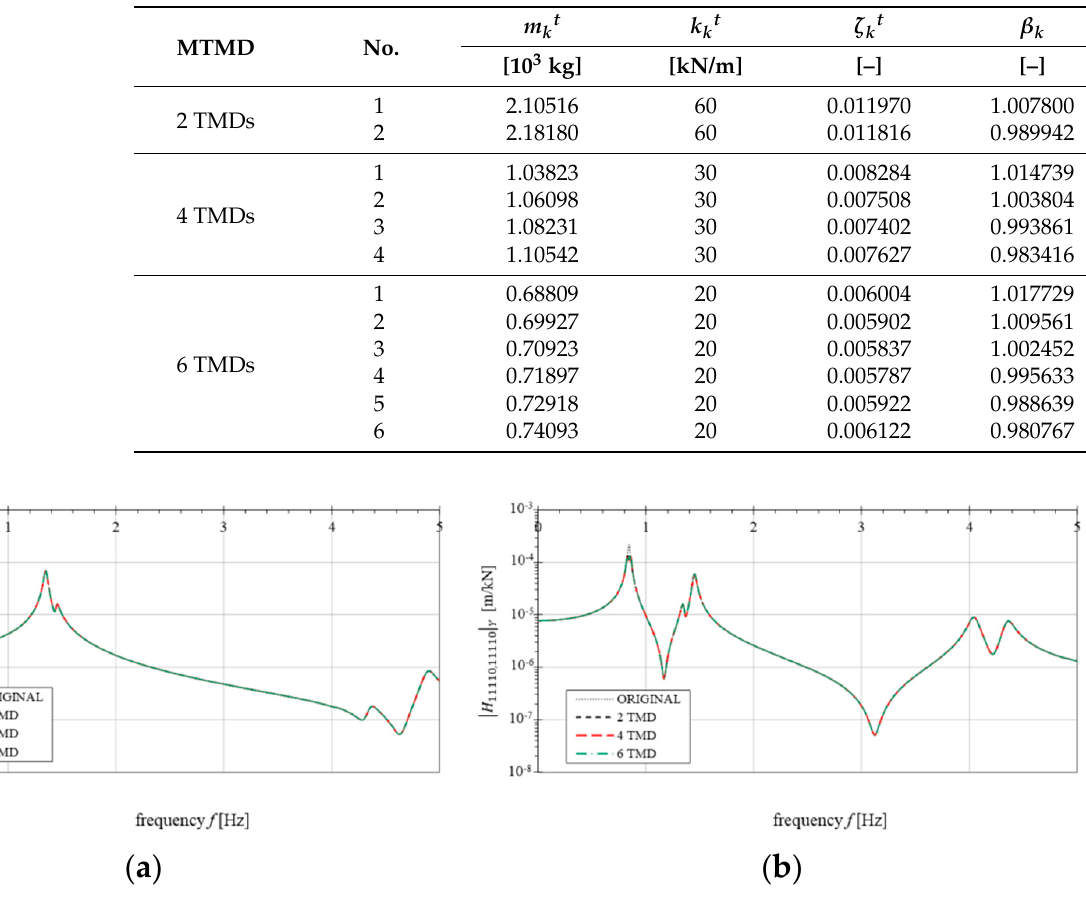
Table 8. Optimal m kt , ζ kt , β k values obtained for the J 2 objective function.